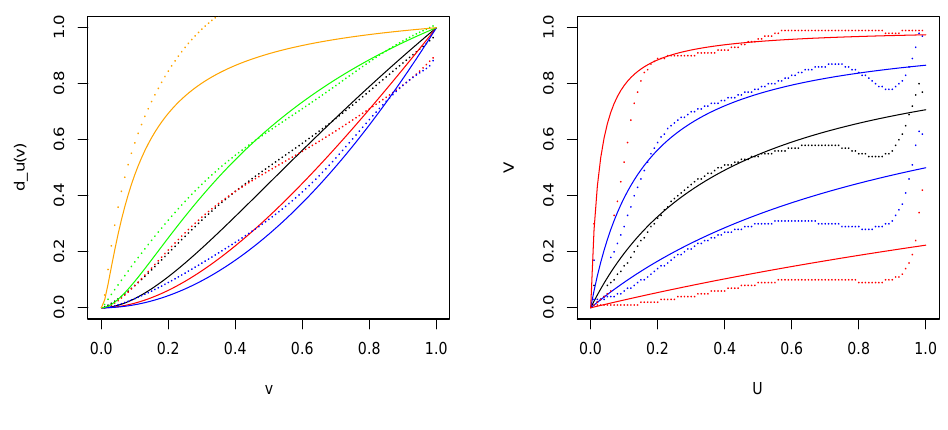
Figure 14: Kernel estimations (left) obtained from eq. (3.3) for d u ( v ) of the model ( U , V ) in Example 2.2 for u = 0.05, 0.25, 0.5, 0.75, 0.95 (dotted lines from the top). Quantile regression curves (right) for q = 0.5 (black), q = 0.25, 0.75 (blue) and q = 0.05, 0.95 (red). The continuous lines represent the exact